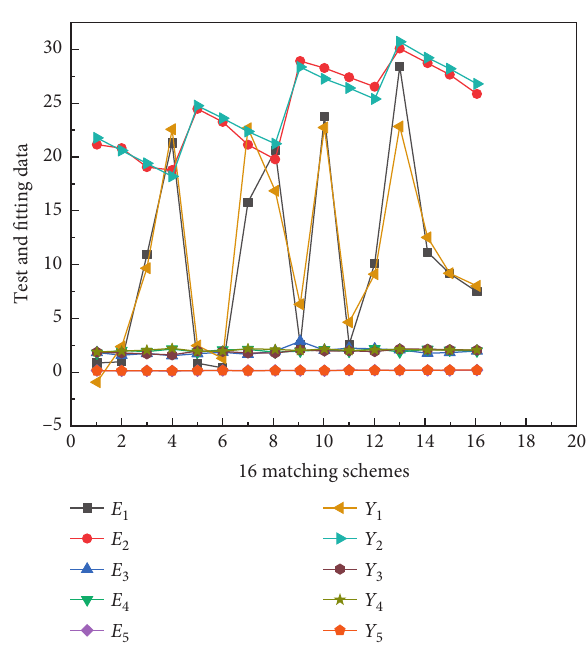
Figure 7: Comparison of test data and fitting